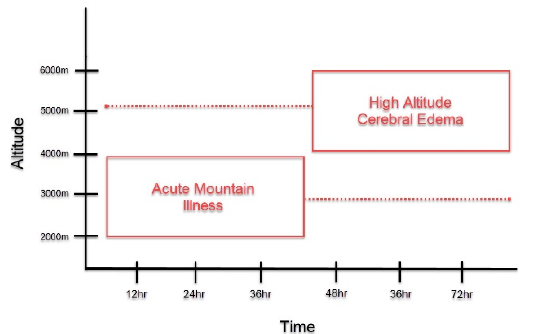
Figure 1. Symptom Onset of Acute Mountain Illness (AMS) and High Altitude Cerebral Edema (HACE). This graph depicts the symptom onset of AMS and HACE as it relates to altitude and length of exposure to high altitudes. As compared to HACE, AMS generally presents at lower altitudes HACE and with earlier symptom onset. At the time that AMS symptoms peak, if altitude is sufficient, the onset of HACE may occur. However, as depicted in the figure, this time course is not absolute. AMS may present in a delayed fashion, while HACE could present acutely.